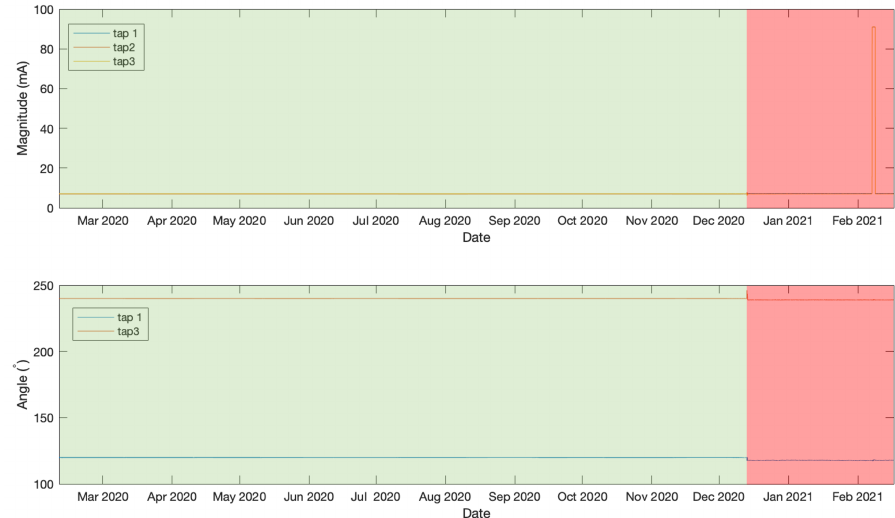
Figure 7. Anomaly detection result on magnitude and angle data in experiment